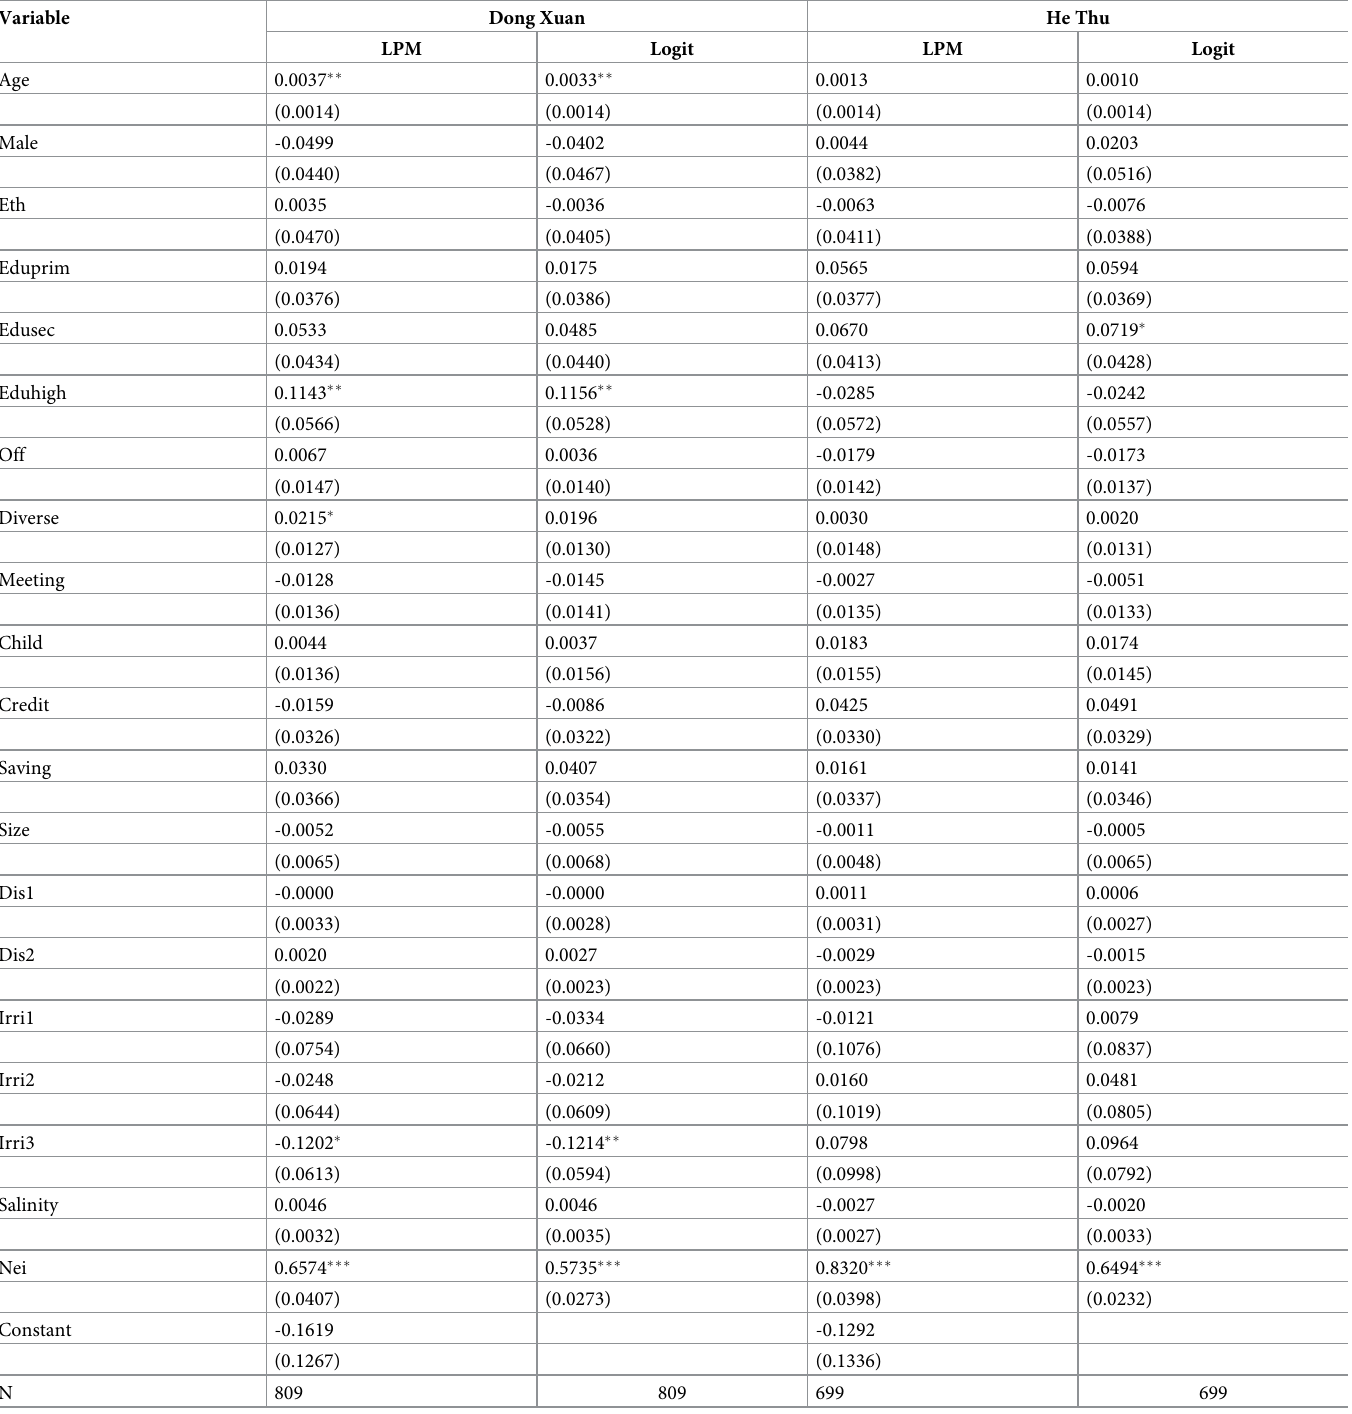
Table 6. Field adoption decision: Linear probability model and logit model by seasons.